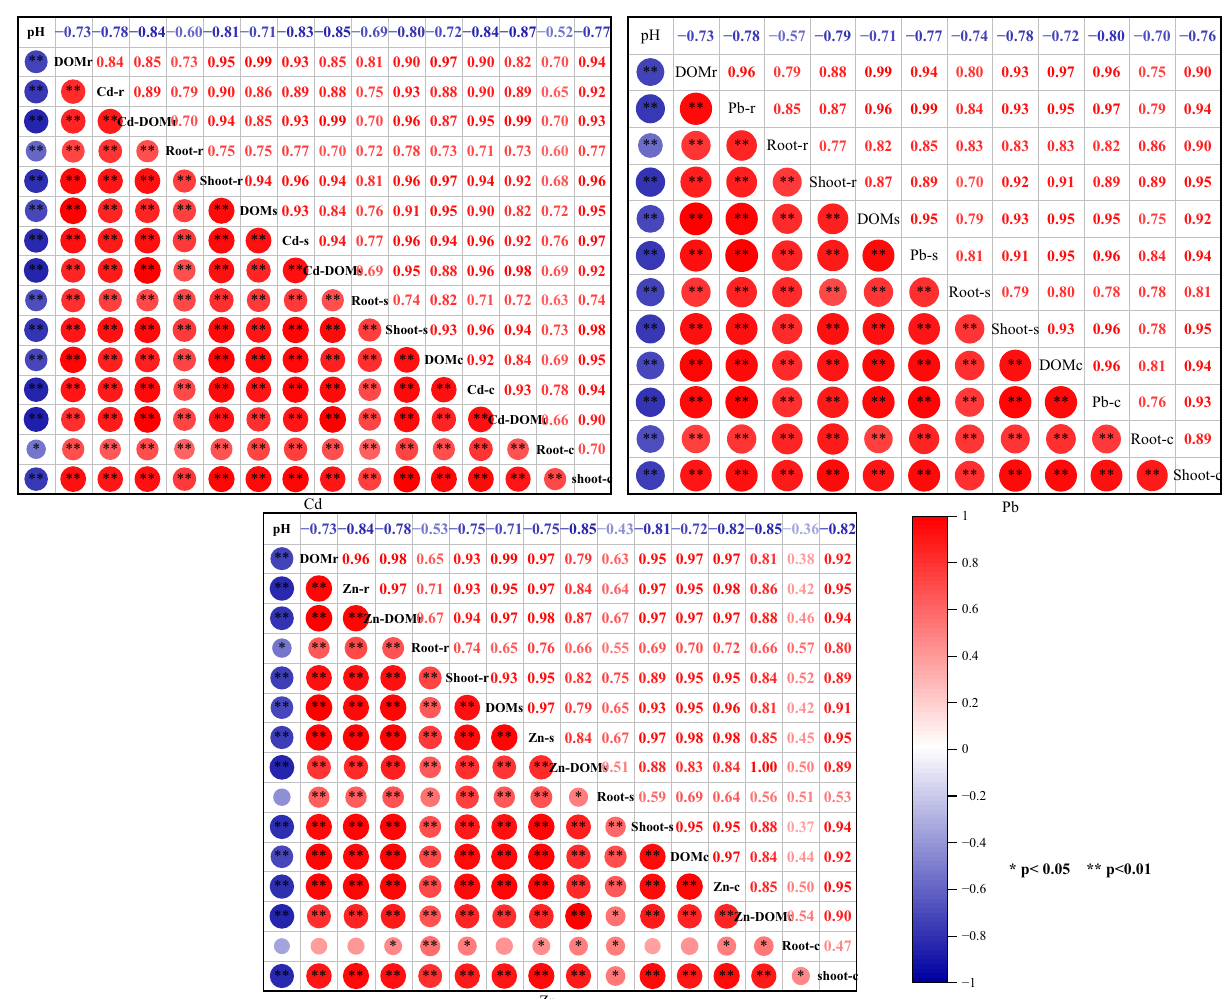
Figure 4. The pearson correlation analysis among pH, DOM concentration, total dissolved HMs, percent of the complex of HMs-DOM and uptake content by the shoot or root of S. alfredii . *The lowercase letter of r, s and c stand for the treatment of DOMr, DOMs and DOMc, respectively, and the total dissolved HMs denoted as Cd-, Zn-,